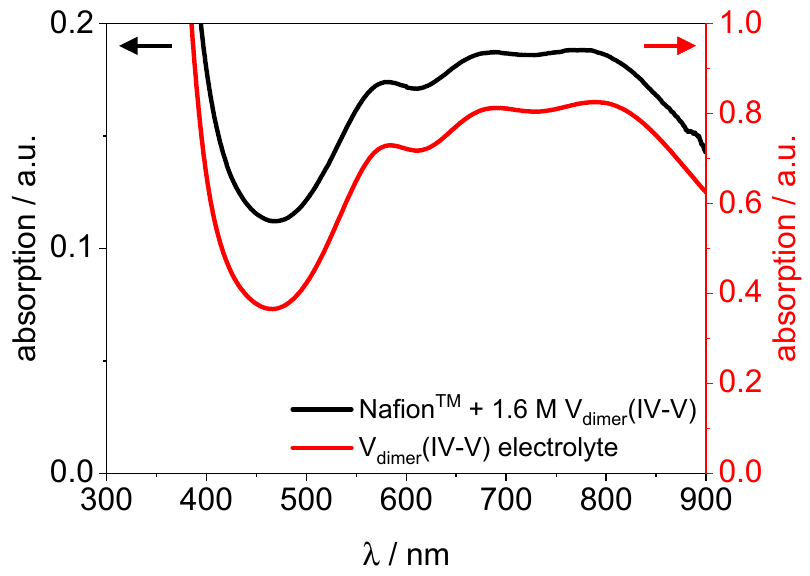
Figure 10. UV/VIS spectra of Nafion™ hydrated with V dimer (IV–V) and 1.6 M V dimer (IV–V) electrolyte. The spectrum of the V dimer (IV–V) uptake experiment in Nafion™ shows strong ab- sorption at 575 nm, 680 nm, and 795 nm, just as the dimer spectrum of the electrolyte. Consequently, the results indicate that the V dimer (IV–V) dimer diffuses into the membrane. That applies only partly for membranes soaked in bathing solutions with concentrations of 0.8 M, 0.4 M, and 0.16 M (s. Figures S2–S6). The finding suggests that for bathing solu- tions with a concentration of 0.16 M vanadium, the dimer decays in Nafion™, as well. The UV/VIS spectra of a PVDF-based membrane hydrated with V(II), V(III), V(IV), V dimer (IV–V), and V(V) electrolyte are presented in Figure 11. The spectrum from the PVDF-based membrane required background fitting and subtraction for V dimer (IV–V) and V(V) (s. experimental). Figure 11. ( a ): UV/VIS spectra of a PVDF-based membrane hydrated with V(II) and V(III). ( b ): UV/VIS spectra of a PVDF- based membrane hydrated with V(IV), V dimer (IV–V) (corrected), and V(V) (corrected). The spectra of the PVDF-based membrane immersed in V(II), V(III), V(IV), and V(V) are similar to the respective Nafion™ spectra and in agreement with the spectra of the electrolyte obtained in this work (s. Figure S1) and reported in literature [44,66].